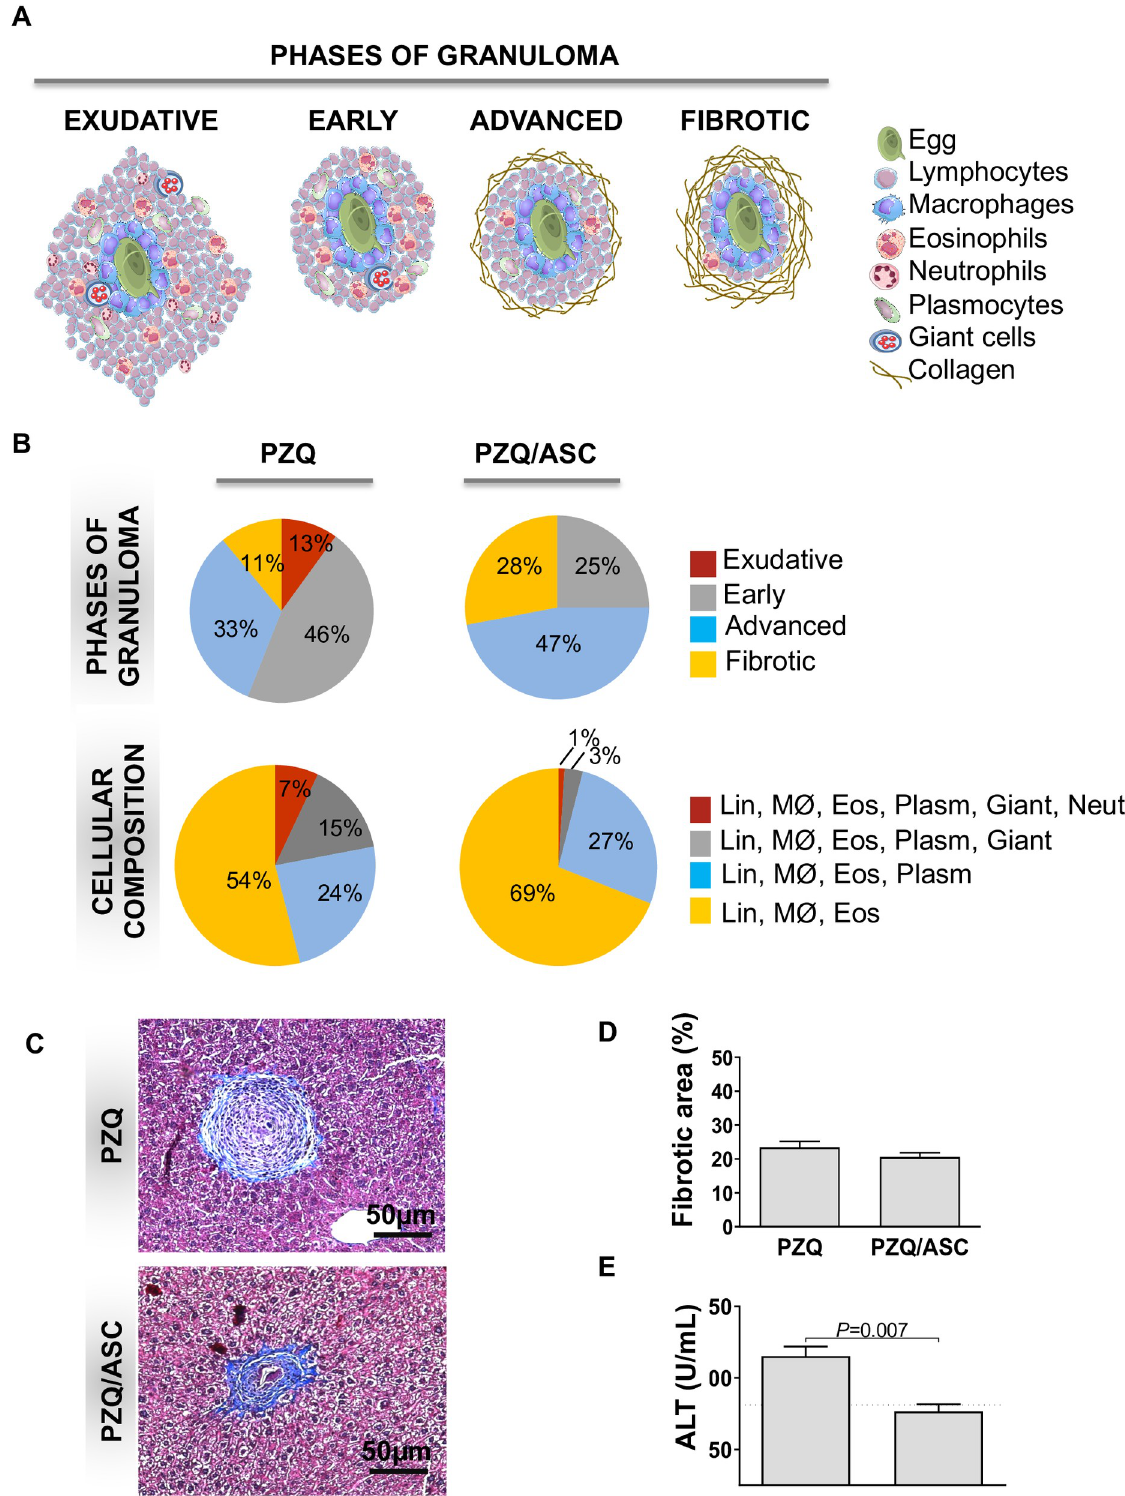
Fig 3. ASC therapy effect on granulomas and ALT levels. Panel A shows a schematic representation of the phases and cellular composition of granulomas. The exudative phase is characterized by the establishment and organization of the granulomatous reaction with focal